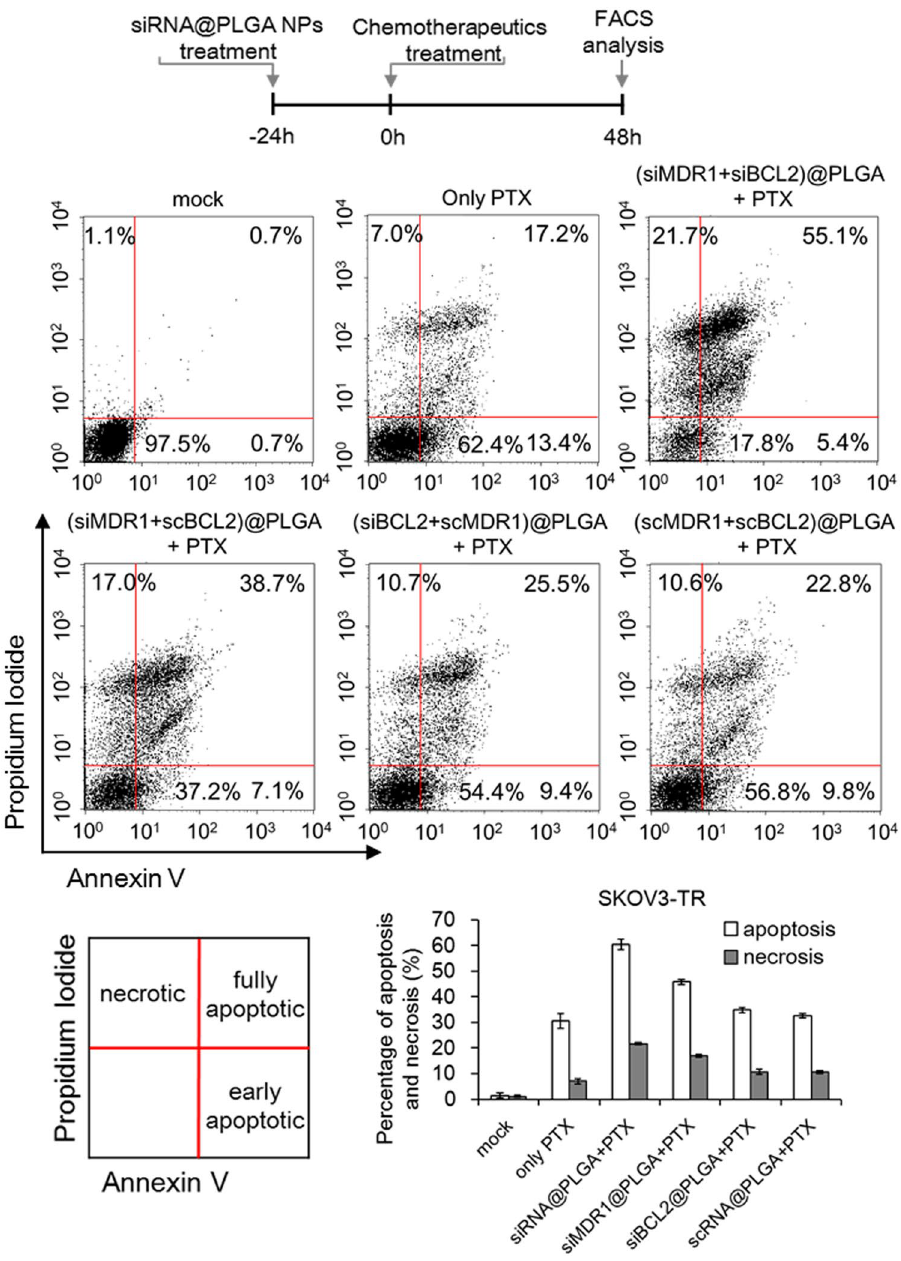
Figure 6. Induction of apoptotic and necrotic cell death on MDR ovarian cancer cells by combination treatment. MDR SKOV3-TR cells were treated sequentially with PLGA NPs containing MDR1 and BCL2 siRNA (37.5 nM, respectively) and paclitaxel (5 μ M), as represented in a schematic diagram. Based on flow cytometry, induction of apoptosis and necrosis was investigated in triplicate, and a representative experiment set is demonstrated here. Each percentage of fully apoptotic, early apoptotic, and necrotic cells were indicated in the corresponding quadrant, and also plotted below. Both the fully and early apoptotic cells are included in the percentage of apoptosis, and the results are shown as the mean ± s.d. (n =